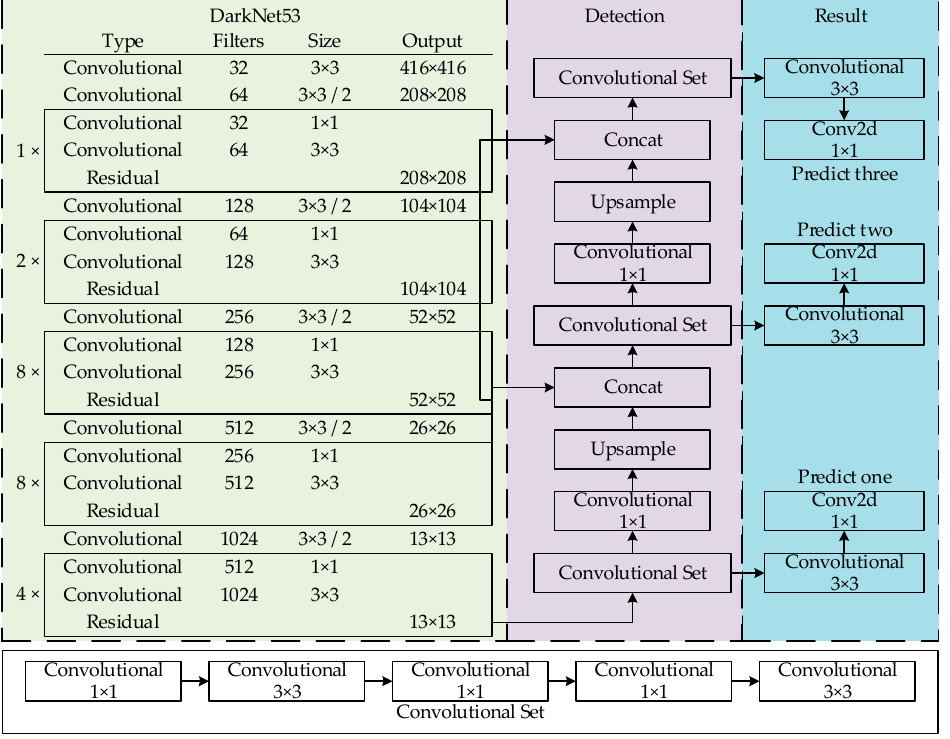
Figure 1. YOLOv3 network structure.